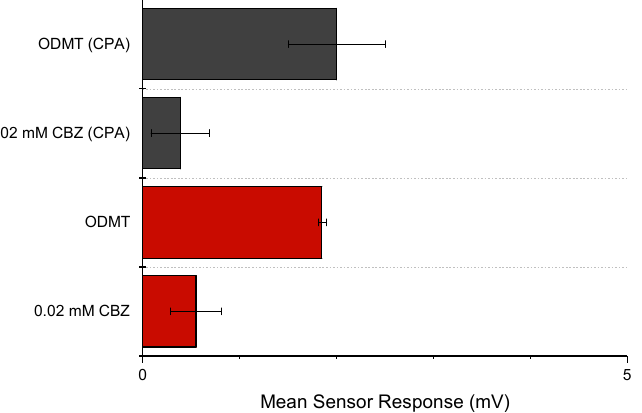
Figure 14. AC0 response of CBZ ODMT reacting compared with pure CBZ, including initial taste and CPA.